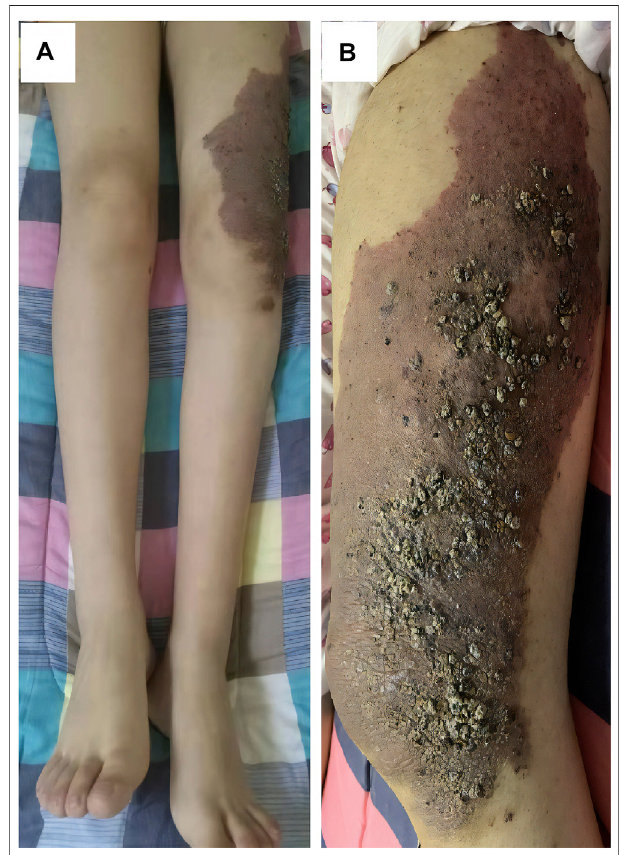
FIGURE 1 | This patient had bone and soft-tissue hypertrophy (A) , port wine stains (B) and varicosity (B) involving her left thigh.